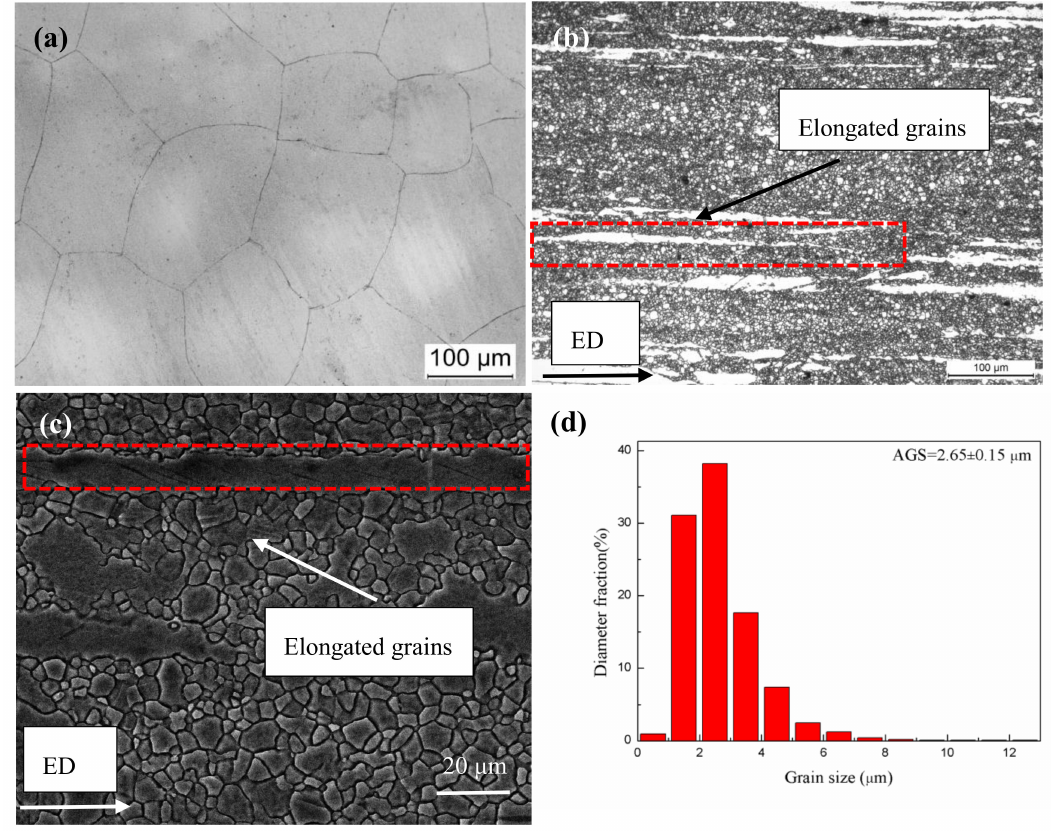
Figure 1. ( a ) Optical microscope (OM) micrograph of homogenized alloy, ( b – d ) OM and scanning electron microscope (SEM) micrographs, dynamic recrystallized (DRXed) grain-size distribution map of extruded